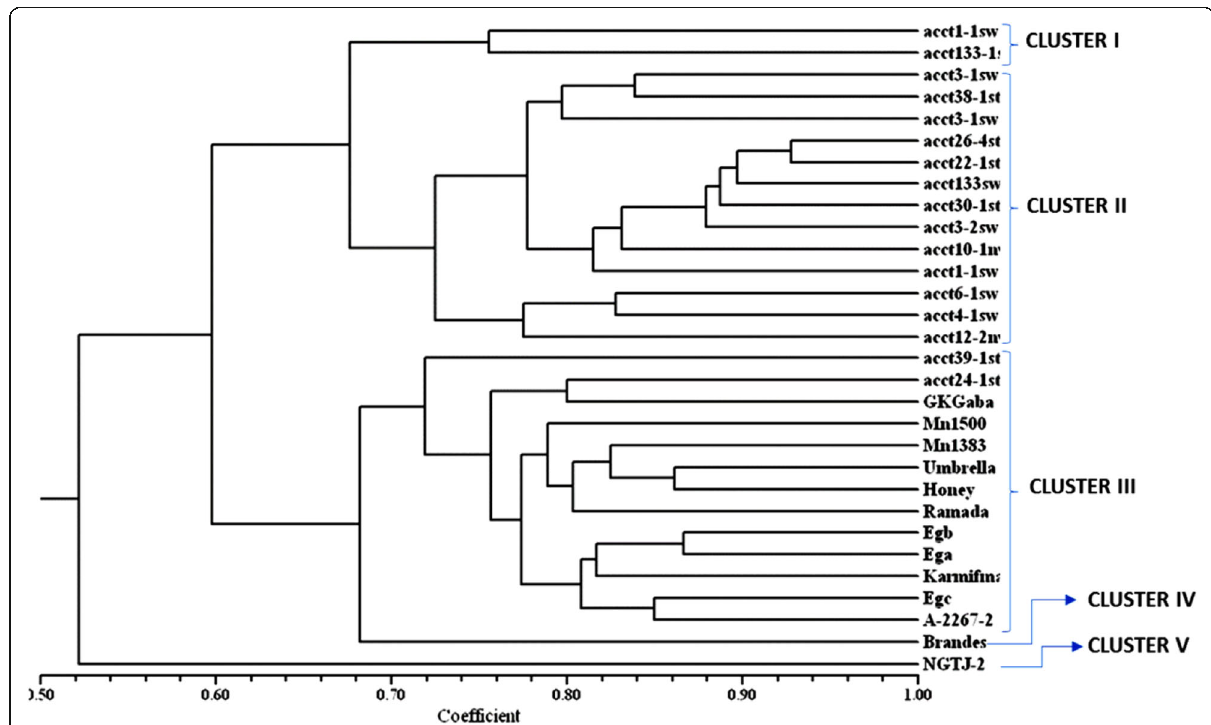
Fig. 2 UPGMA cluster analysis based on 24 TRAP marker combinations showing similarity among 30 sweet sorghum based on similarity index